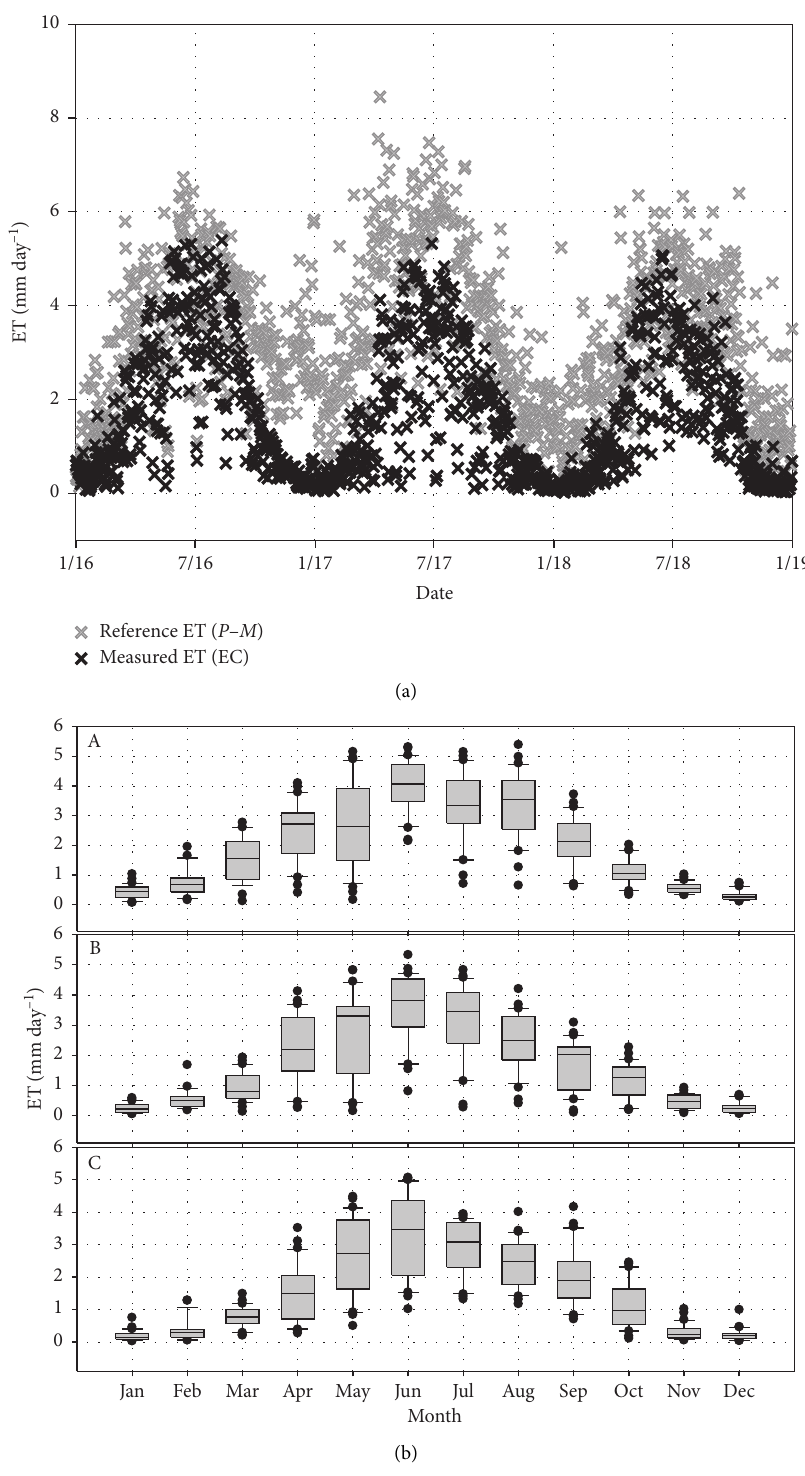
Figure 2: (a) Daily rates (mm day − 1 ) of measured (black) evapotranspiration flux (EC) and reference Penman–Monteith ( P – M ) evapotranspiration. (b) Median daily measured evapotranspiration rate (mm day − 1 ) for each month by year. Boxes bounding the inner quartiles and whiskers indicate 50% and 95% of the median values of ET. A: 2016. B: 2017. C: